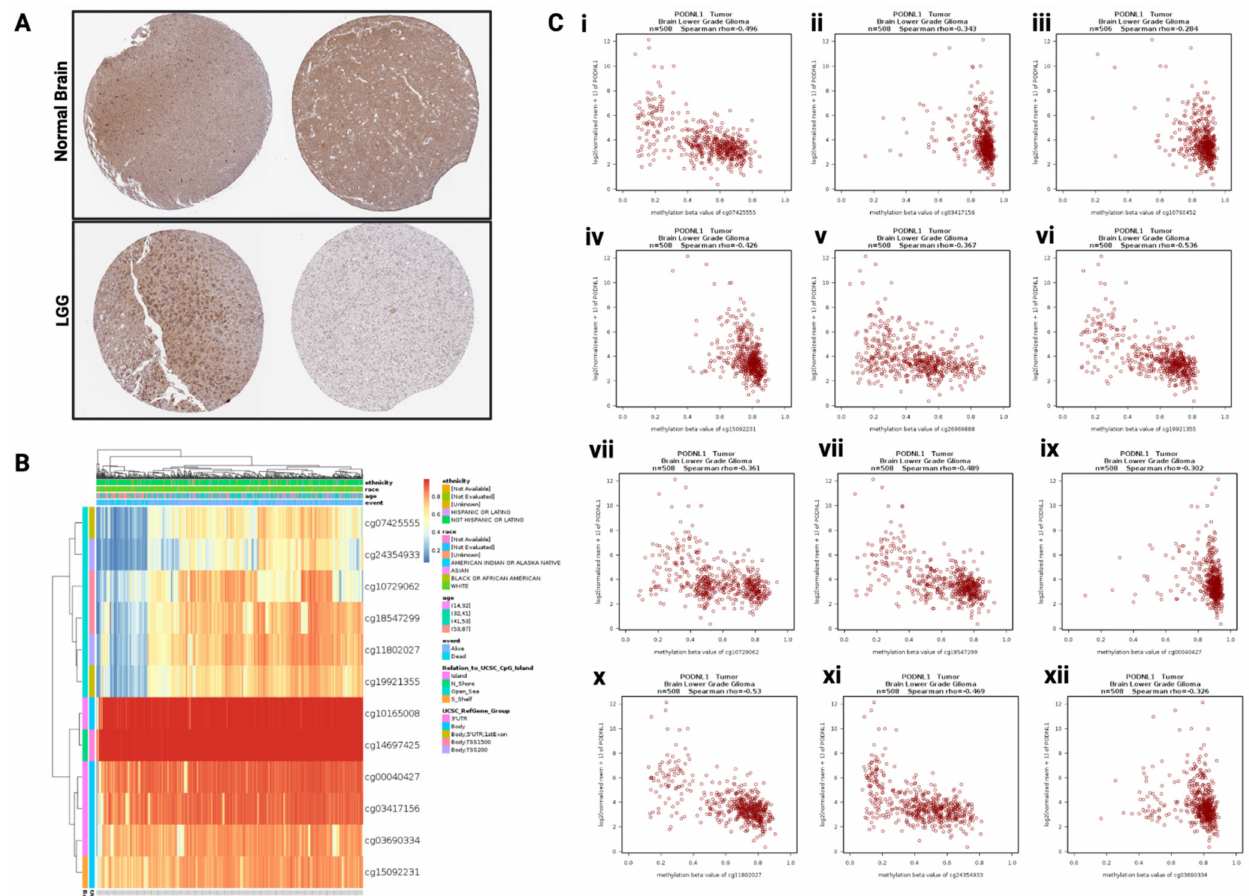
Figure 1. PODNL1 protein expression, CpG methylations, and its correlation with PODNL1 mRNA levels. ( A ) Immunohis- tochemical images showing PODNL1 protein expression in normal brain and lower-grade glioma (LGG) tissues (Human Protein Atlas). Weak PODNL1 expression in glial cells and moderate expression in neuronal cells were reported in normal brain tissues. Moderate expression was reported for one LGG sample (left), while weak expression was reported in the other (right). ( B ) Heatmap showing methylation levels in the top twelve PODNL1 CpG loci in TCGA-LGG (MethSurv). ( C ) ( i – xii .) Correlation between TCGA-LGG PODNL1 CpG methylations (beta-values) and PODNL1 mRNA expressions (RSEM+1) ( p < 0.05 for all). Spearman’s rho correlation coefficients are reported within each